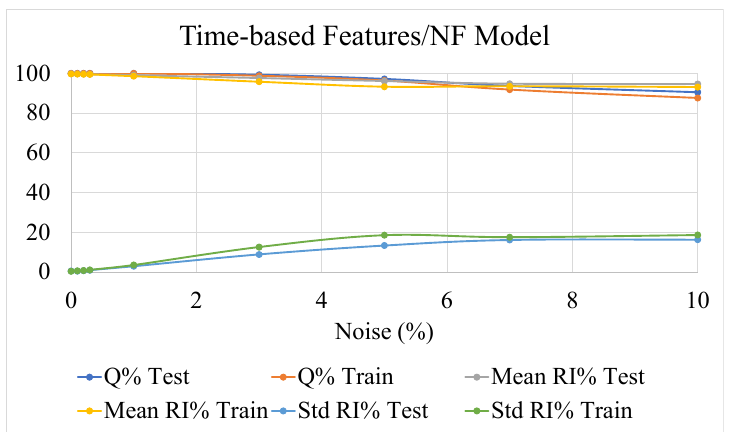
Figure 10. The behavior of the Neuro Fuzzy inference systems fed by time-based features, as a function of different levels of noise added to the dataset. Results for indexes (6), (13), and (14) calculated for reliability index (7) are shown.